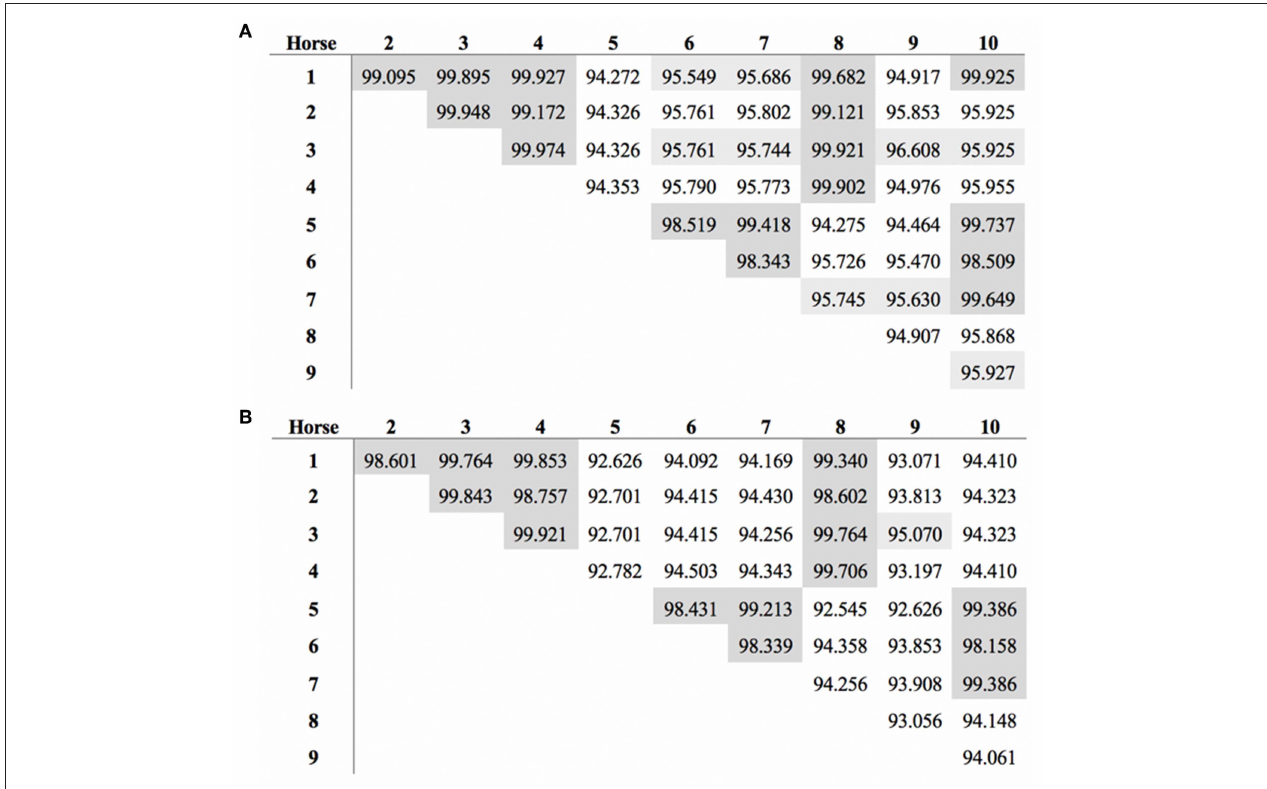
FIGURE 8 | Similarity in SALSA (A) nucleotide and (B) amino acid sequence among 10 different horses. Shading indicates higher similarity.